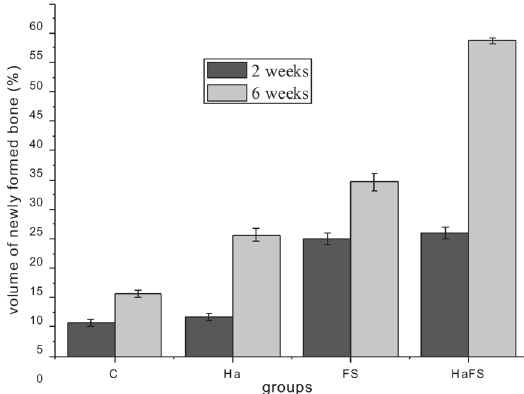
Figure 6. Morphometric analysis demonstrating the percentage of newly formed bone in 2 and 6